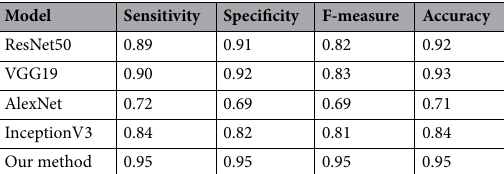
Table 3. Experimental